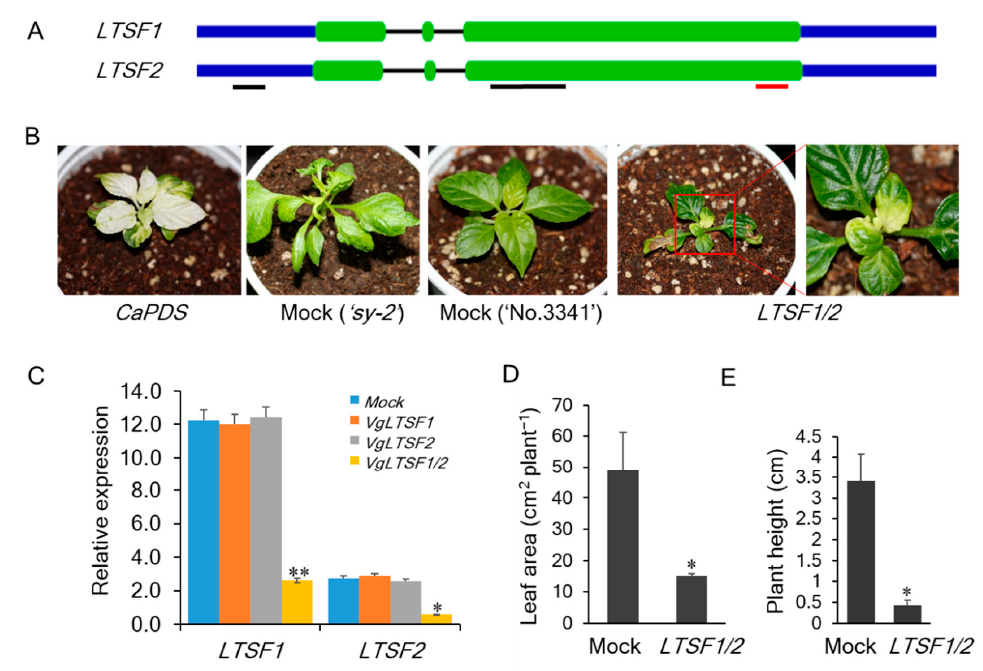
Figure 2. Virus-induced gene silencing (VIGS) of the pepper LTSF1 and LTSF2 genes in wild-type (‘No.3341’) plants. ( A ) Schematic structure of the LTSF1 and LTSF2 gene sequences. Closed green boxes and solid black lines indicate exons and introns, respectively. Blue lines indicate untranslated regions (UTRs). The VIGS target sites in LTSF1 and LTSF2 are underlined with black lines and qPCR target region is underlined with red line. ( B ) VIGS pepper phenotypes. Pepper plants with VIGS of Capsicum phytoene desaturase ( CaPDS ) showed a photobleaching phenotype. The double silencing of the LTSF1 / 2 genes resulted in plants with an abnormal phenotype. The rightmost image is a magnification of the area highlighted by a red square. ( C ) Quantitative PCR (qPCR) analysis of plants in which LTSF1 and/or LTSF2 were silenced using VIGS ( Vg ). VgLTSF1 and VgLTSF2 refer to the VIGS constructs targeting the